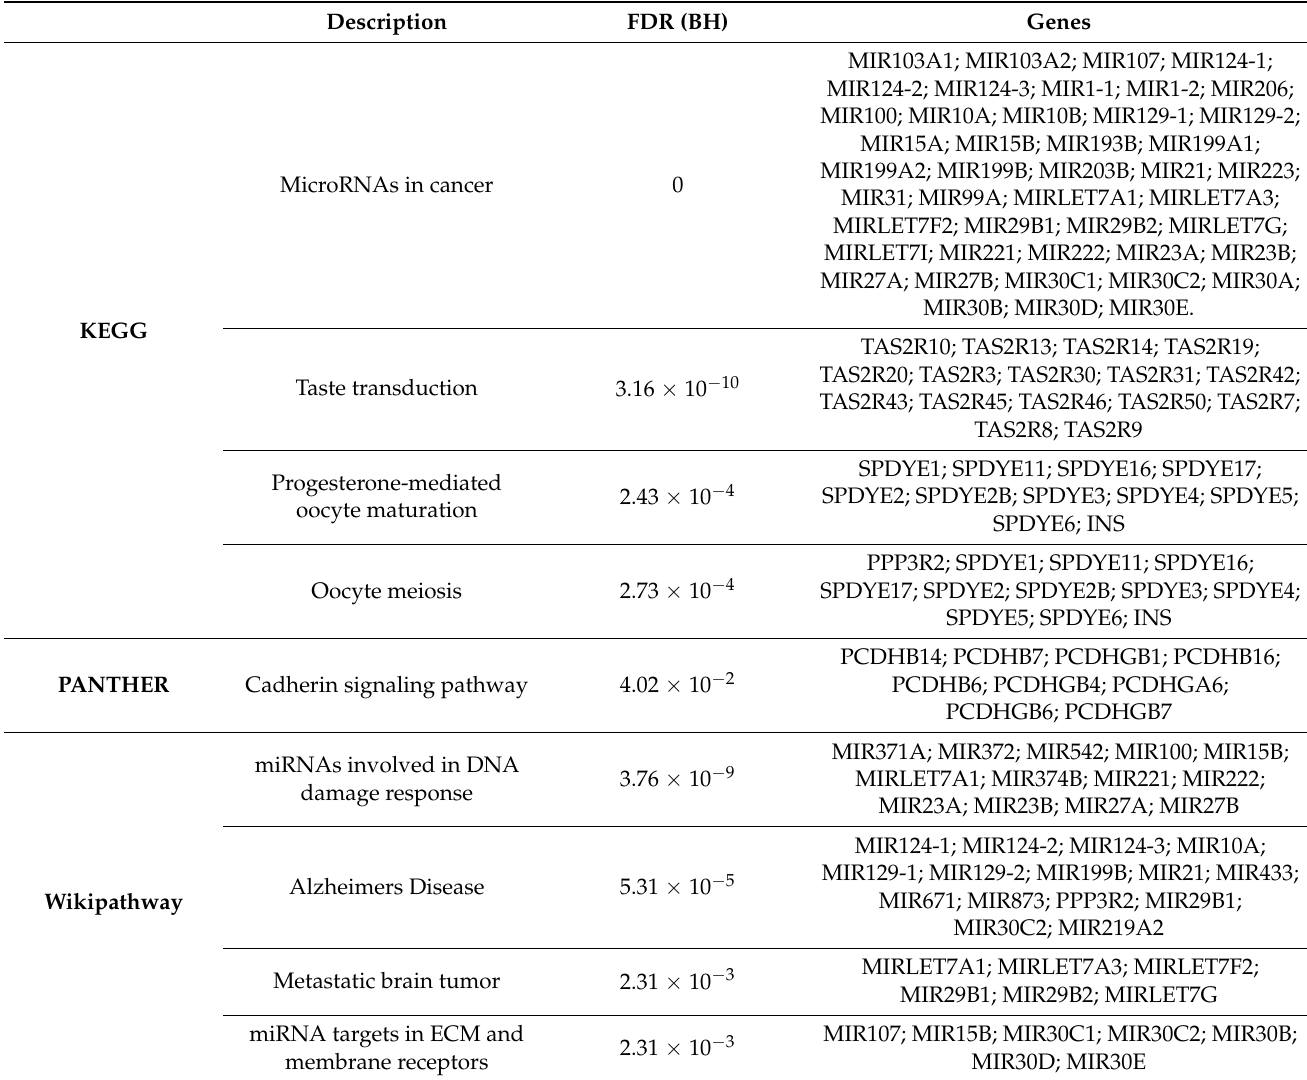
Table 2. Pathway analysis. Gene Over-Representation Analysis (ORA) using KEGG, PANTHER and Wikipathway. The enrichment test used Benjamini–Hochberg’s FDR correction (FDR < 0.05). CNV data were previously analyzed by an unpaired 2-group Wilcoxon test ( p -value < 0.05). Significant genes altered in their number of copies within the entire genomic landscape were used to perform the ORA analysis, which highlighted a significant enrichment in microRNAs and cancer-related